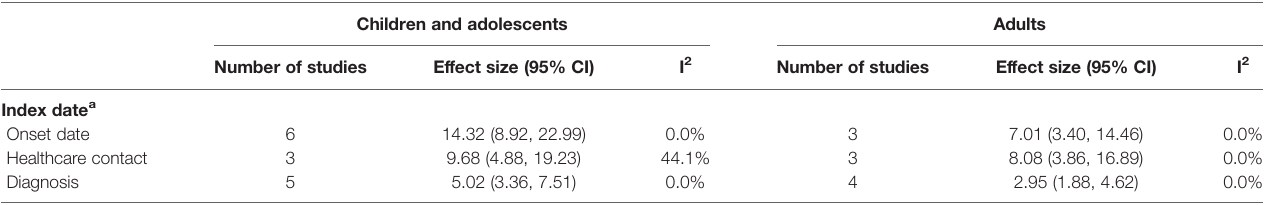
TABLE 4 | Systematic review of vaccination with Pandemrix and risk of